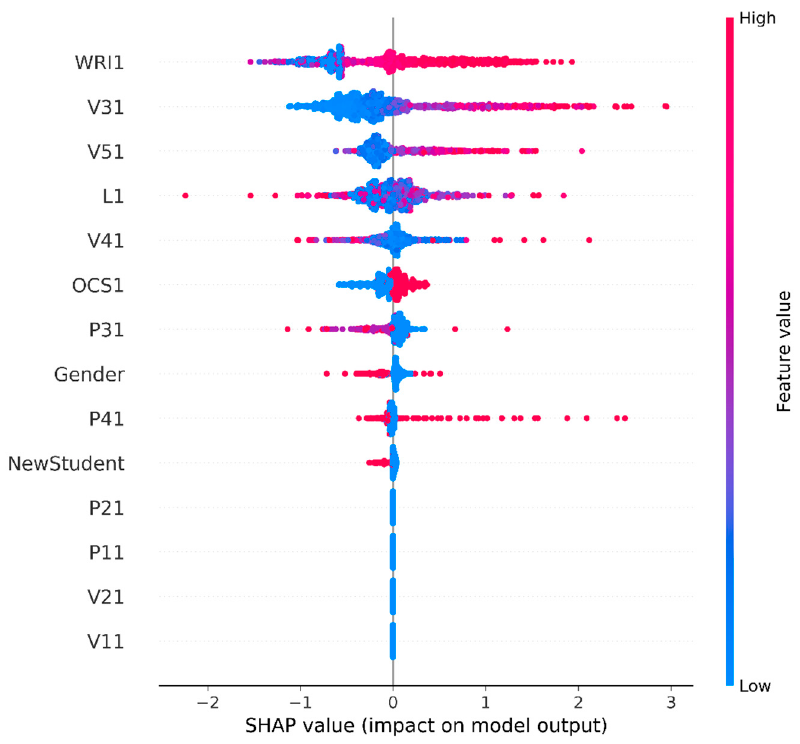
Figure 6. KernelSHAP values of the GB (ls) regressor ( D 1 dataset).